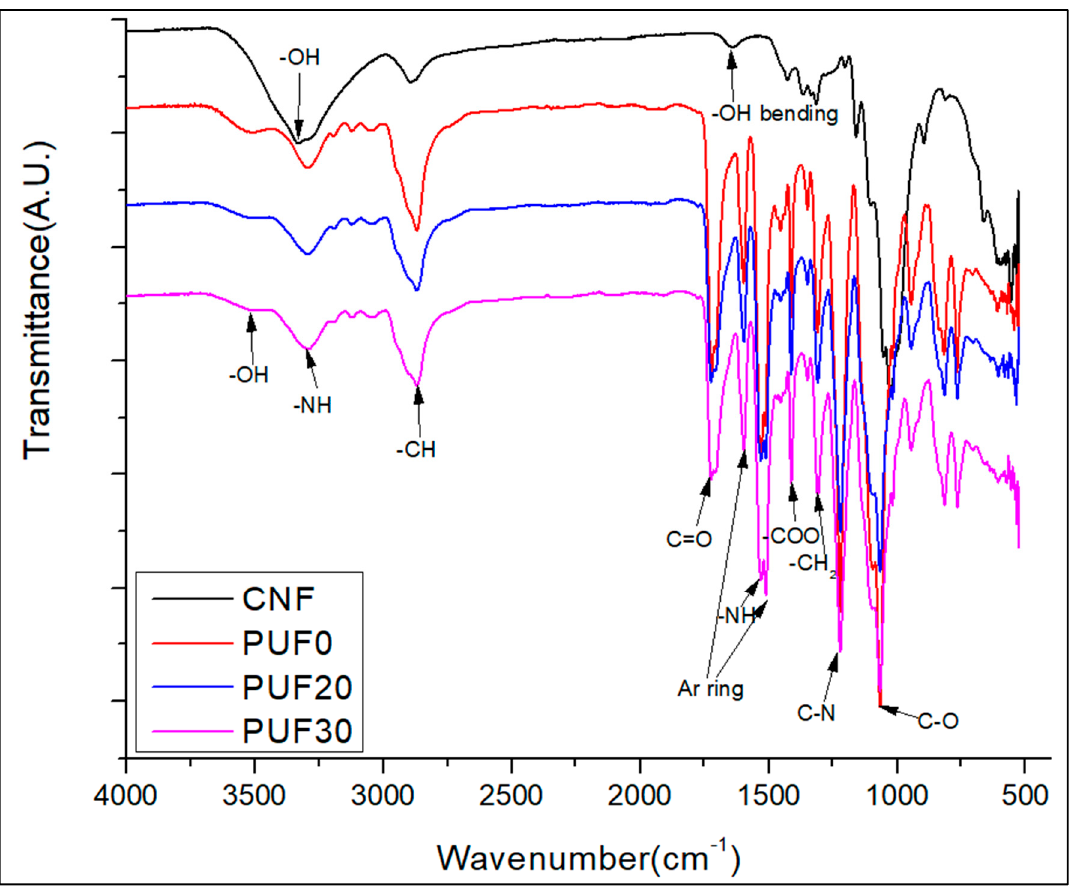
Figure 1. FTIR spectra of CNF and PUF. Figure 2. FTIR spectra of CNF and